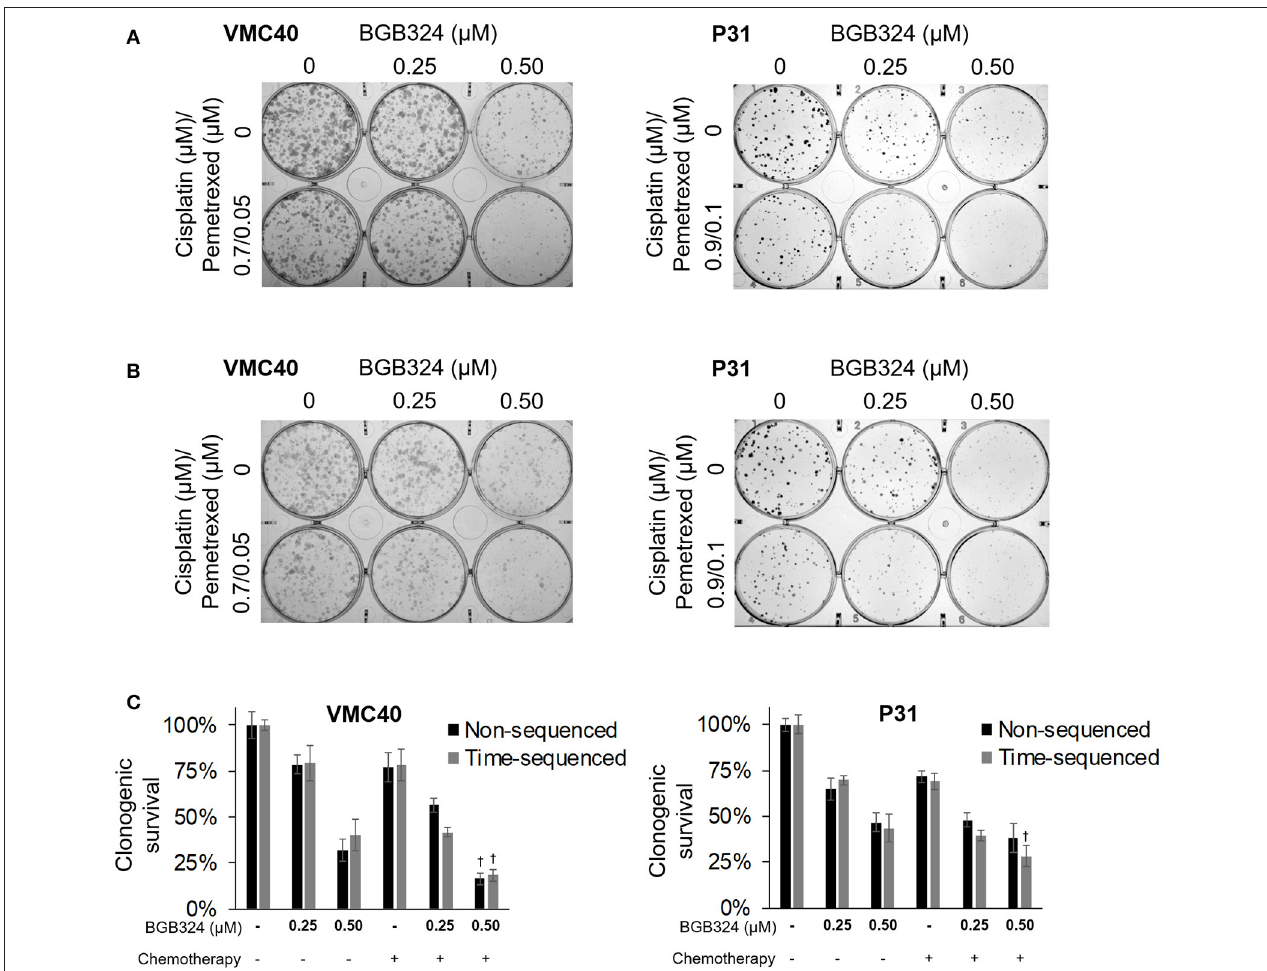
FIGURE 7 | Combination of BGB324 with both cisplatin and pemetrexed. (A) Representative images of clonogenic assays after 72h treatment with BGB324, cisplatin, and pemetrexed. (B) Representative images of clonogenic assays after 4-h pretreatment with BGB324 followed 72h treatment with both cisplatin and pemetrexed. (C) Quantification of (A,B) by measuring quantity of stain from cells. † Denotes p < 0.05 via t -test for value compared to values of BGB324 alone. Error bars represent ± SEM of three